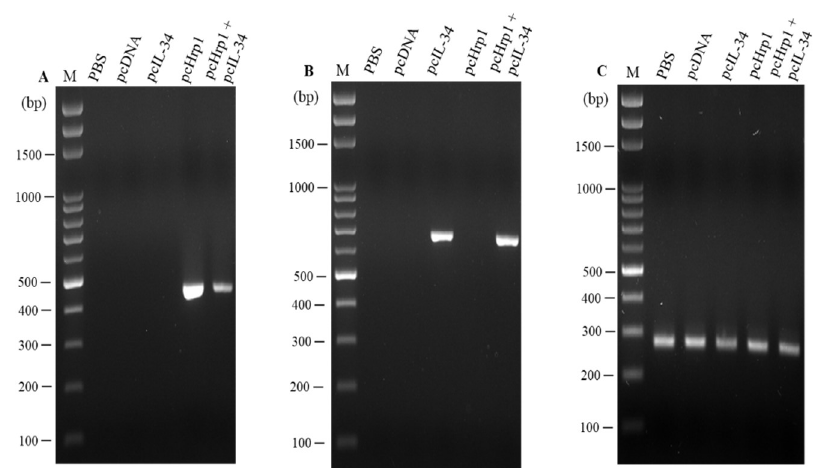
Figure 6. RT-PCR analysis of the Hrp1 gene and exogenous IL-34 gene in the muscle tissue of vaccinated fish 21 days post-vaccination. ( A ) Hrp1 gene; ( B ) exogenous IL-34 gene; ( C ) Rps40 reference gene. M: 100 bp DNA.